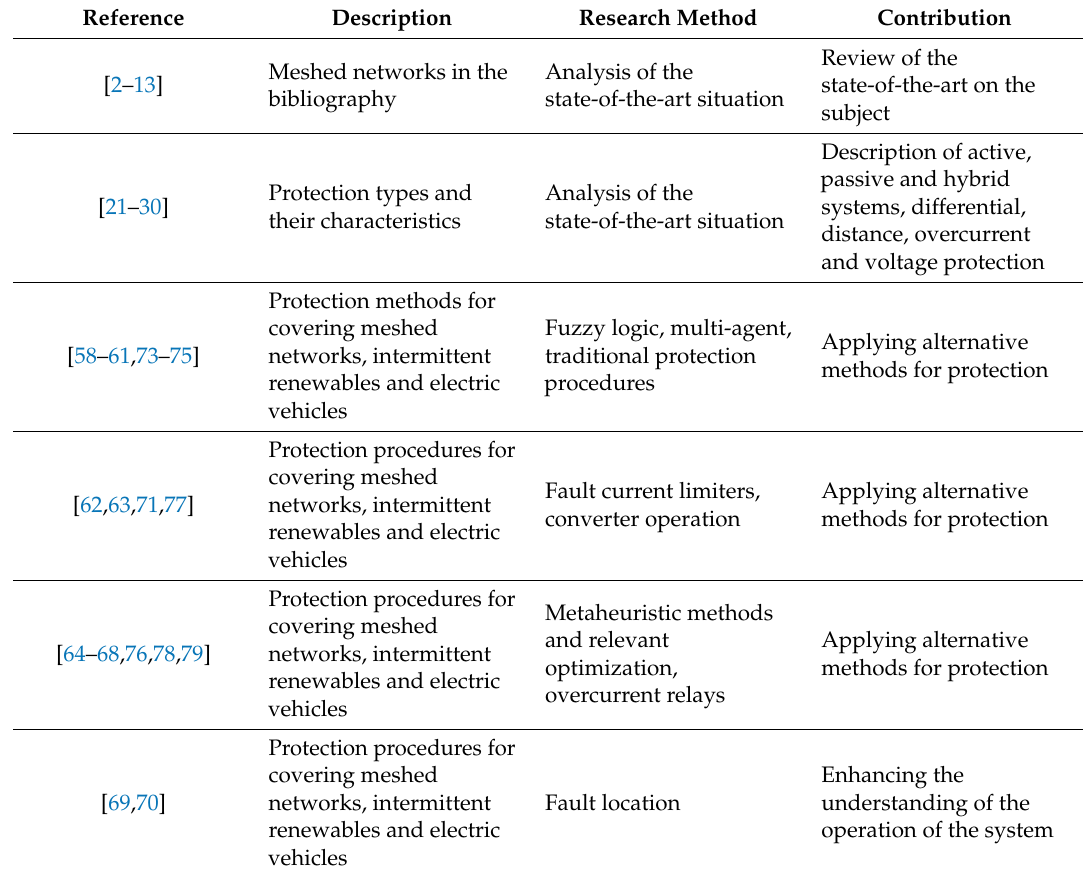
Table 2. Distribution networks protection